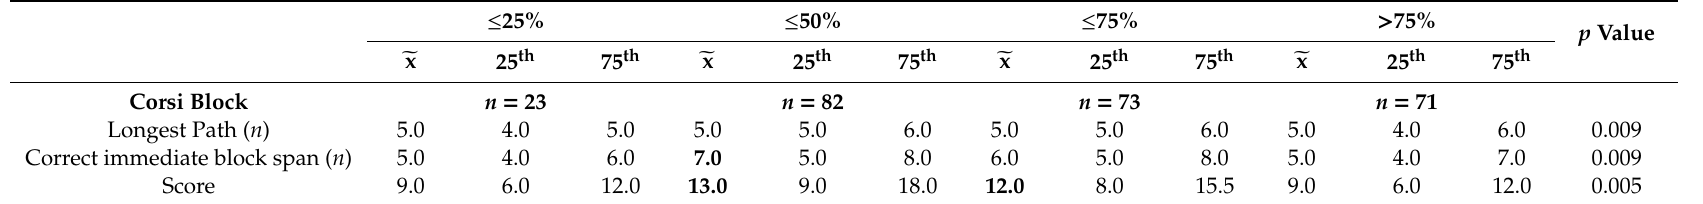
Table 3. Cognitive performance in corsi block-tapping task between the four water categories (% of